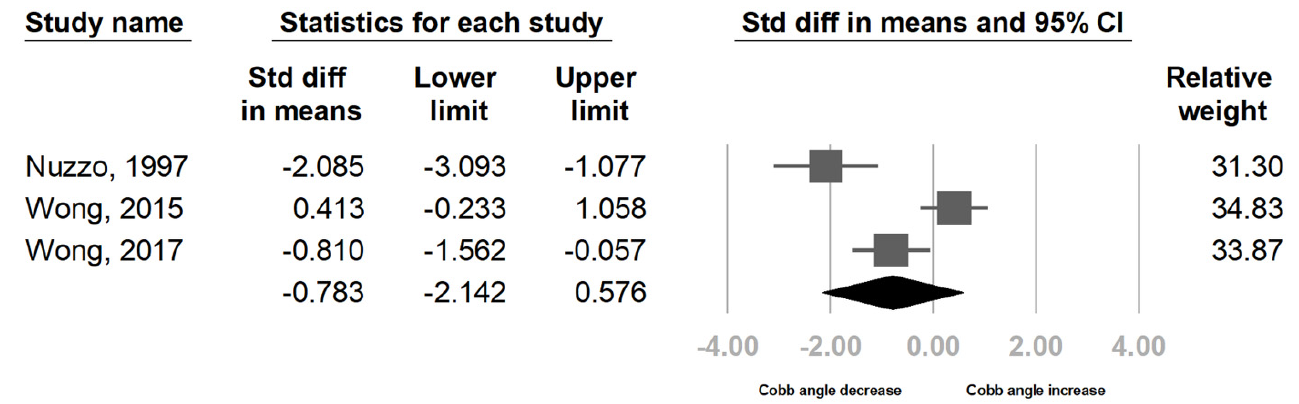
Figure 4. Forest plot of standardized mean differences in reduction in Cobb angle after treatment. Effect of individual studies were presented by squares. 95% CI was presented by lines. The summarized effect size was presented by diamond.